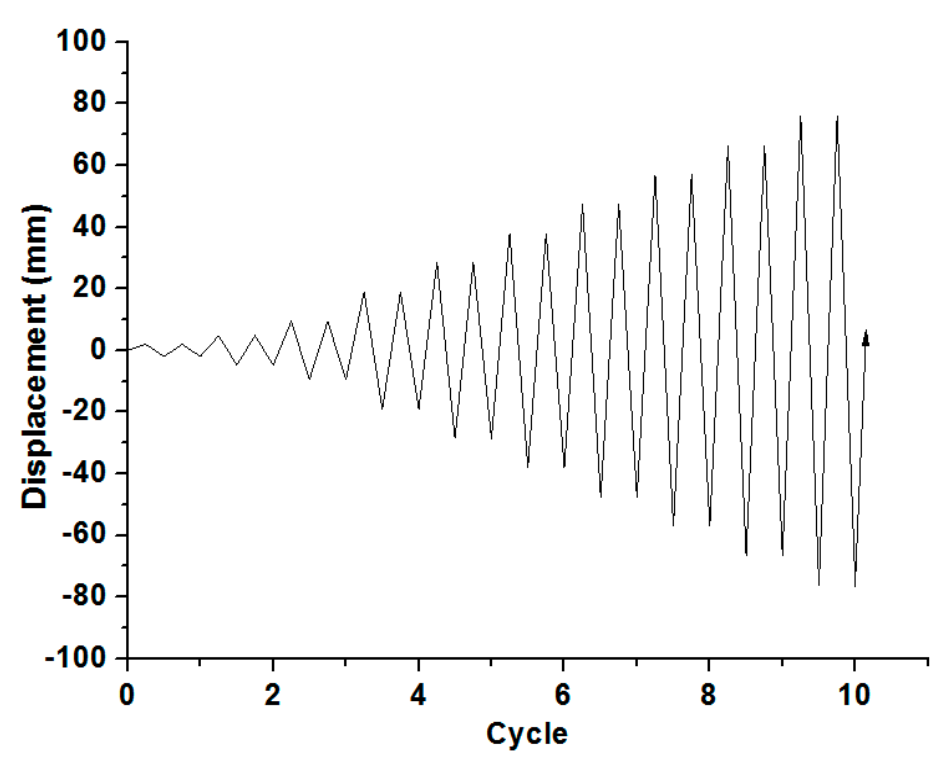
Figure 6. Cyclic loading history by displacement control.